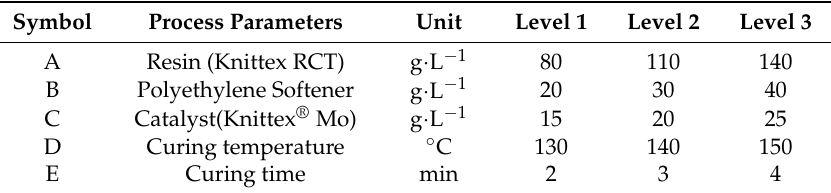
Table 1. Parameters and their levels.